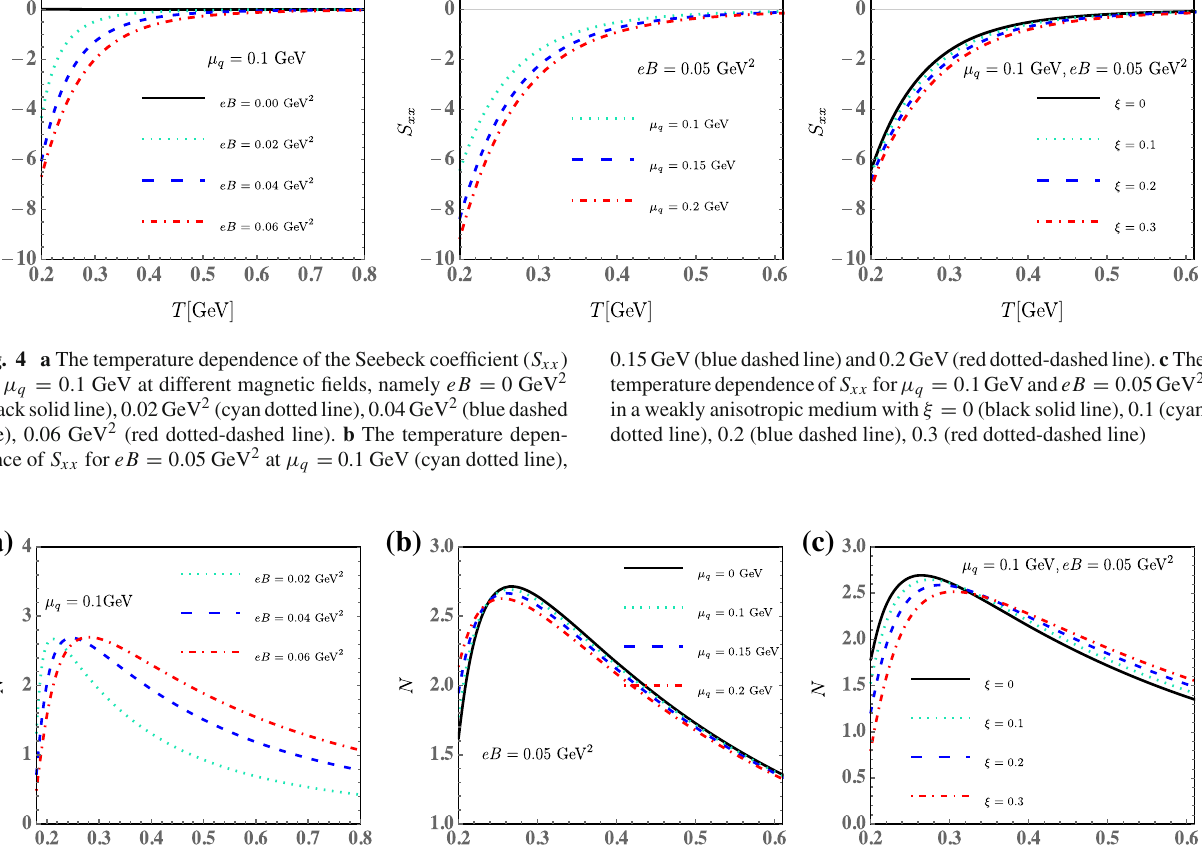
(blue dashed line) and 0.2 GeV (red dotted-dashed line). c The temper- ature dependence of N for μ q = 0 . 1 GeV and eB = 0 . 05 GeV 2 in a weakly anisotropic medium with ξ = 0 (black solid line), 0.1 (cyan dotted line), 0.2 (blue dashed line), 0.3 (red dotted-dashed